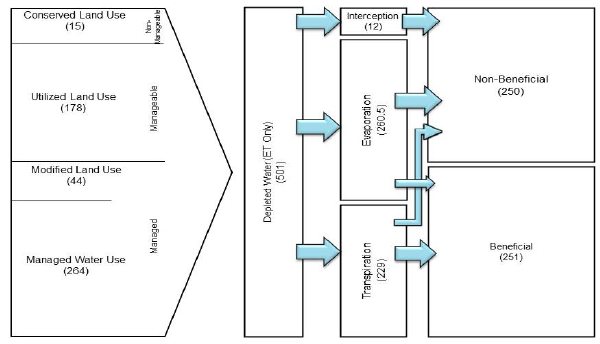
Figure 4. WA+ evapotranspiration sheet for the Indus basin based on 2007 data. All components 3 Fig. 4. WA + evapotranspiration sheet for the Indus basin based on are in km 3 4 2007. All components are in km 3